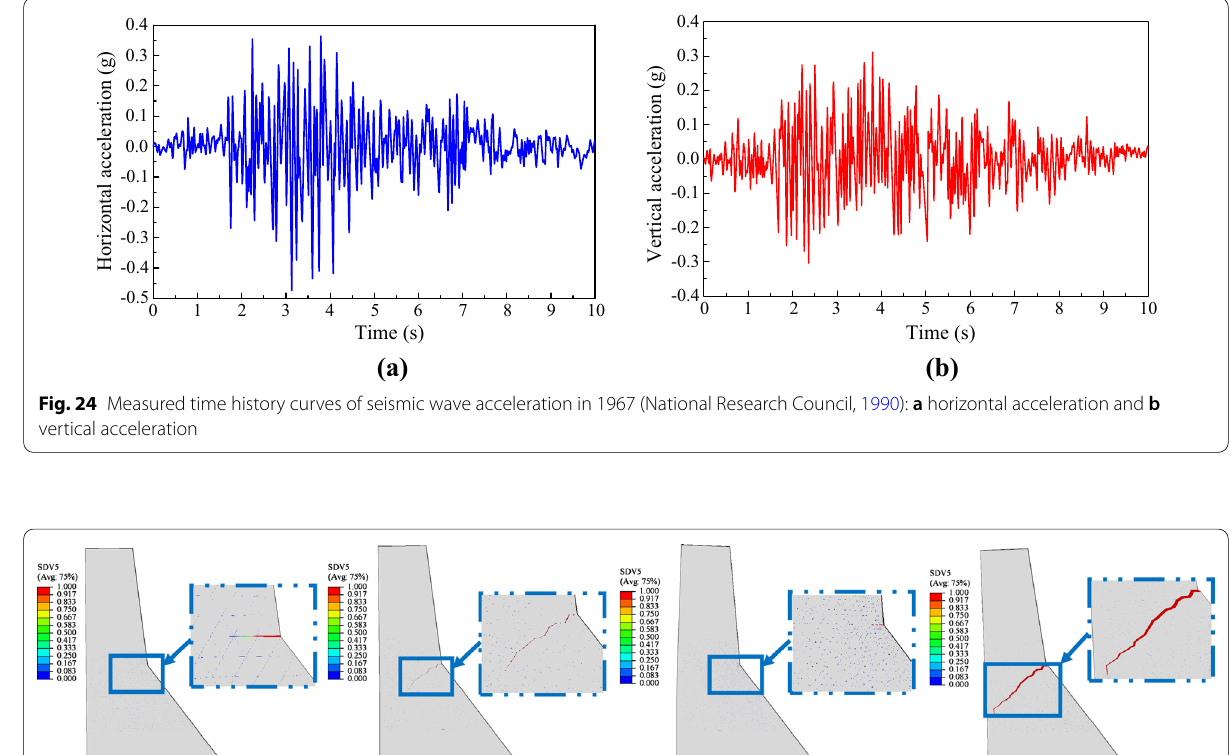
2.70 s, b t 2.74 s, c t 2.9 s, and d t 3.17 = = = =